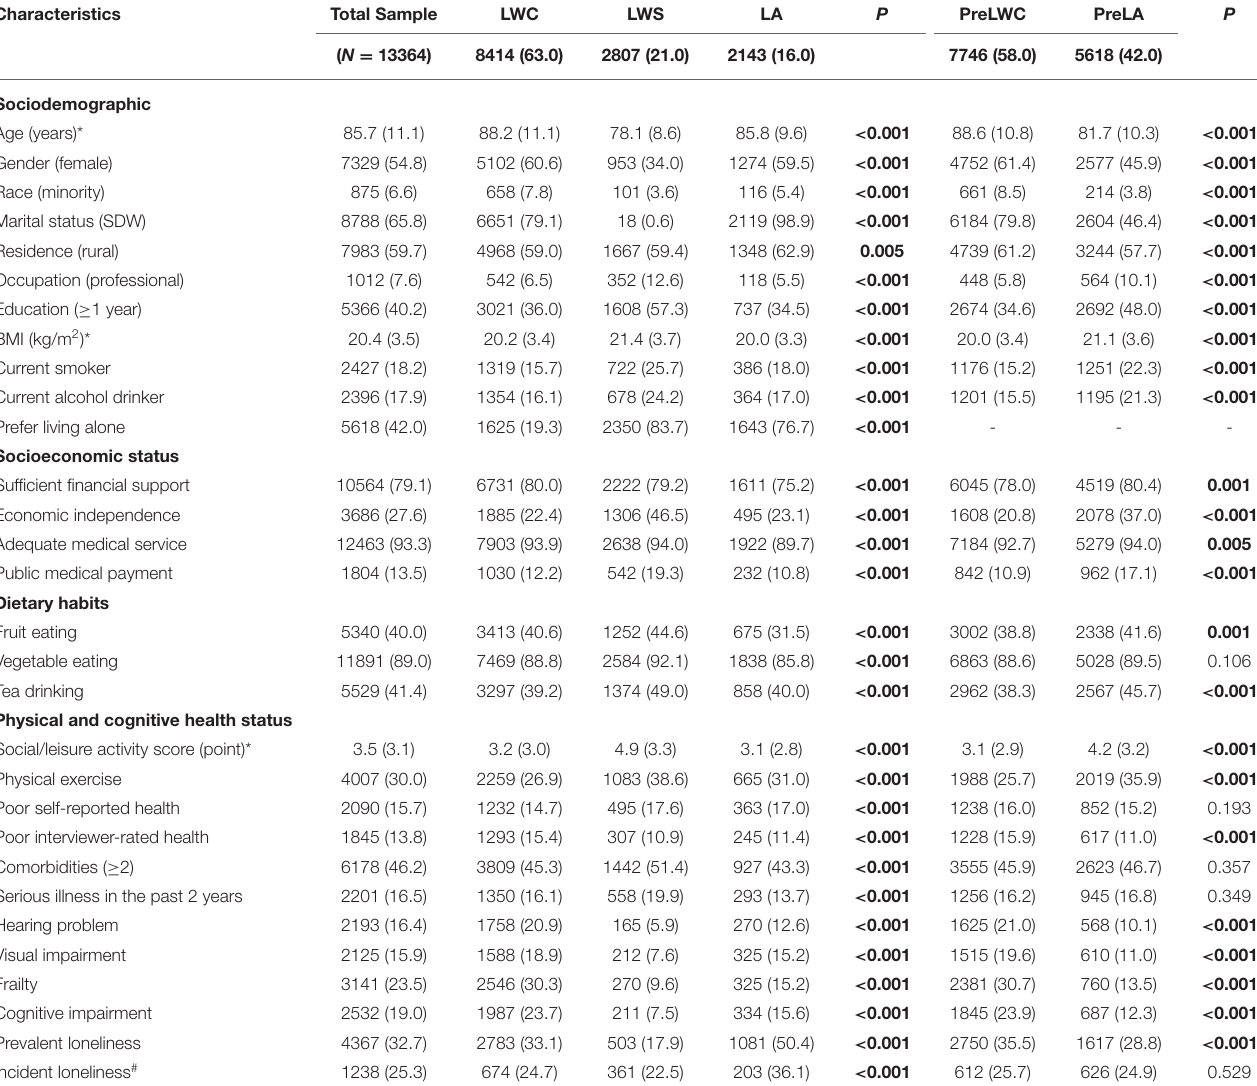
TABLE 1 | Baseline characteristics by living arrangements and living